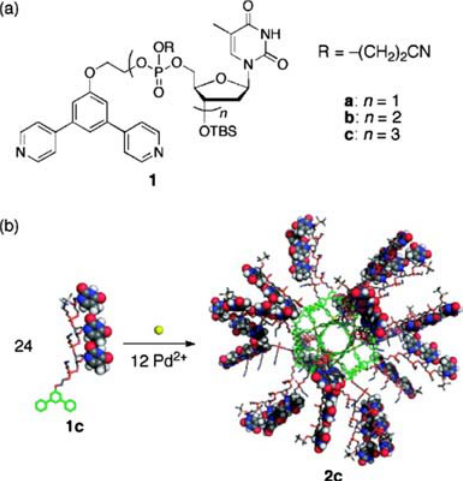
Figure 7. Self-assembly of DNA-displaying coordination nanospheres. (a) Structures of ligands 1a 2 c. (b) Self- assembly of DNA-conjugated molecular sphere 2c from 12 Pd(II) ions and 24 1c ligands. Ligands 1a and 1b also give the corresponding M12L24 spheres (consisting of 12 Pd(II) ions and 24 ligands). Reprinted with permission from (T. Kikuchi; S. Sato; M. Fujita. J. Am. Chem. Soc. 2010, 132 , 15930–15932). Copyright (2010) American Chemical